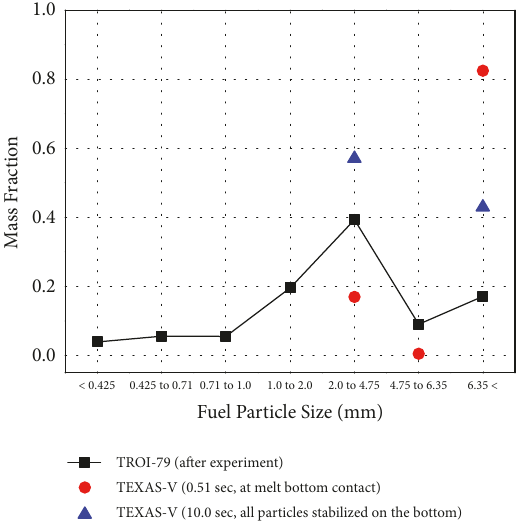
Figure 12: Particle size distribution in the condition for submerged- RV.